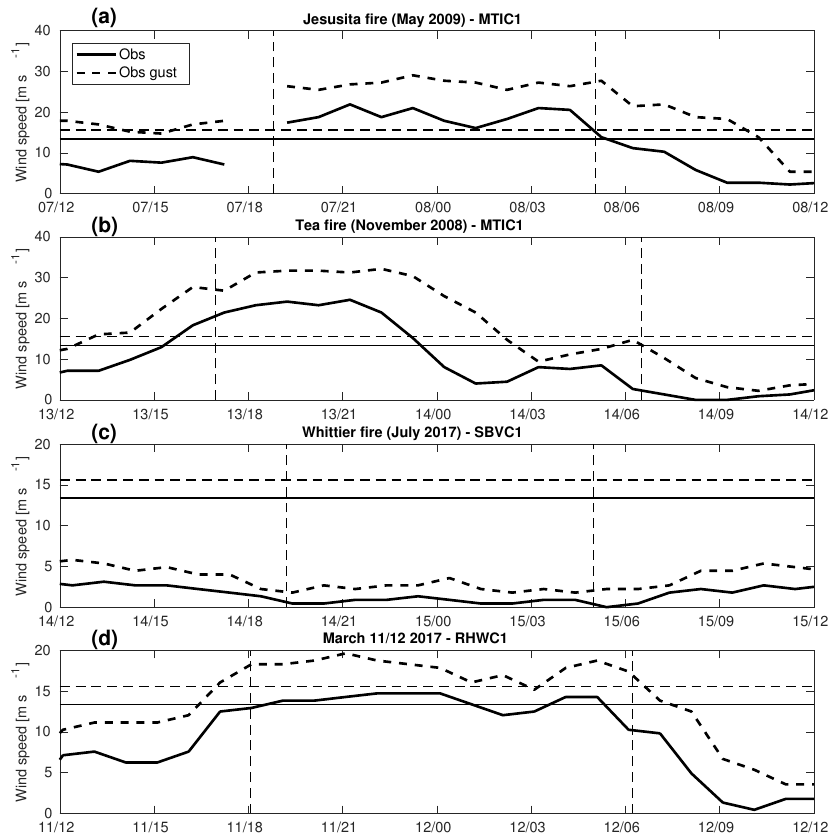
Figure 2. Observed wind speeds (solid lines) and gusts (dashed lines) for the selected Sundowner events during ( a ) the Jesusita fire, ( b ) the Tea fire, ( c ) the Whittier fire, and ( d ) the 11/12 March 2017 case study. Station location in each of the panel titles are given in Table S1 and Figure 1b. Horizontal lines indicate the thresholds for Sundowner wind criteria as used by NWS LOX. Vertical dashed lines denote astronomical sunset and sunrise